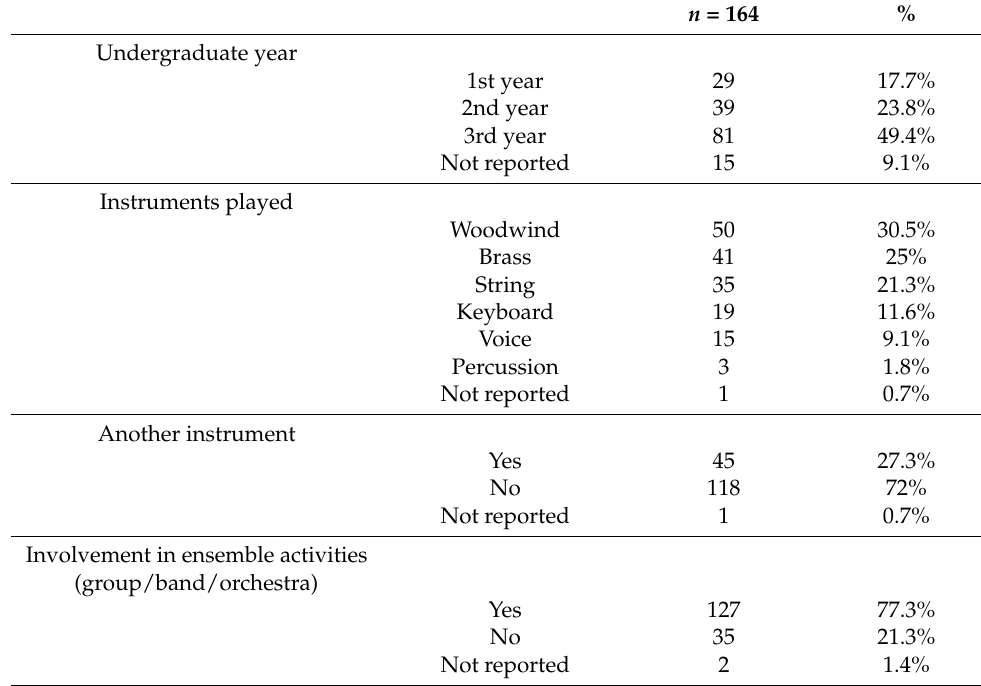
Table 1. Characterisation of